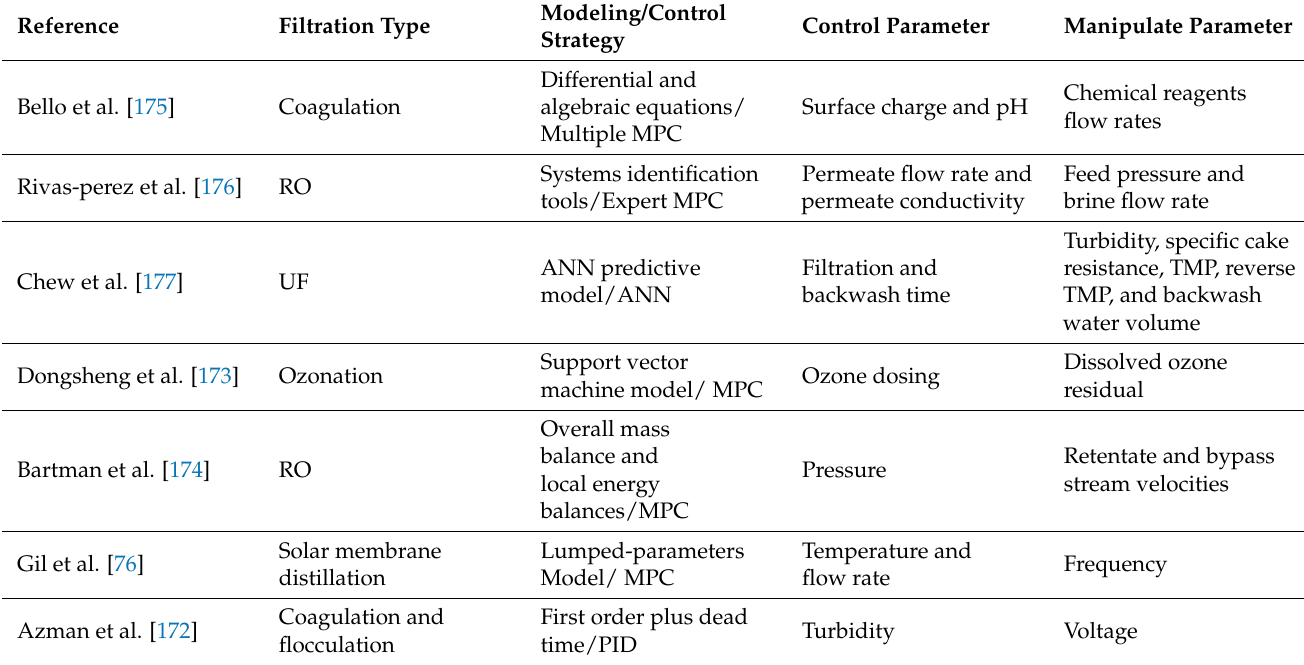
Table 7. Setting of control strategy in drinking water